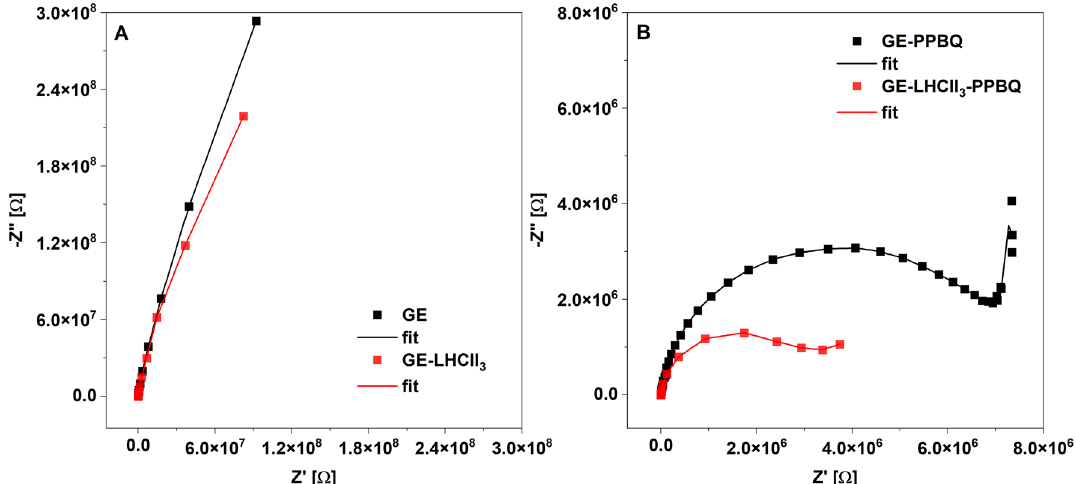
Figure 5. Electrochemical impedance spectroscopy (EIS) spectra recorded for each modification step of the graphite electrode. Nyquist plots for: unmodified GE electrode in HEPES buffer (black squares) and GE in the presence of 0.1 mM PPBQ (GE-PPBQ)(red squares) ( A ), GE modified by 1.5 µl suspension of LHCII 3 in glutaraldehyde matrix (0.2 µg Chl/µl) (LHCII 3 -GE) (black squares) and final biohybrid system GE-LHCII 3 - PPBQ (red squares) ( B ). The EIS spectra were recorded under dark conditions at OCP. The plots are representative of 3 separate experiments.